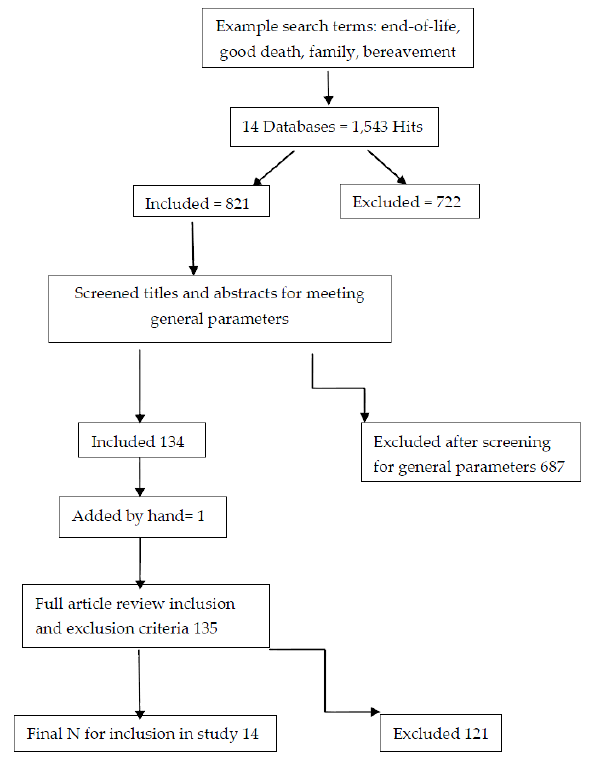
Figure 1. Search Results.